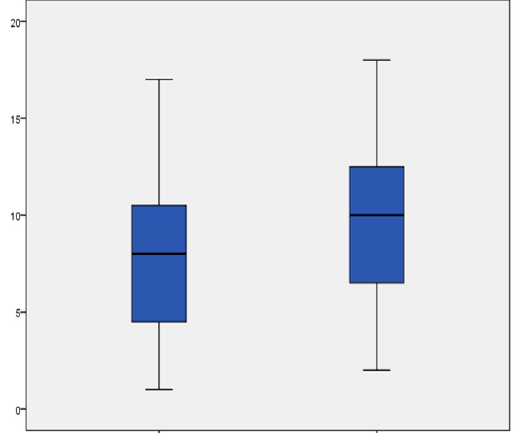
Figure 2. Mixed dmft/DMFT scores at the first (left box) and the recall (right box) visits. The difference was statistically significant ( p = 0.006). Medians are shown as lines inside the boxes, 25th and 75th percentiles as boxes, maximum and minimum values as whiskers; n = 35.